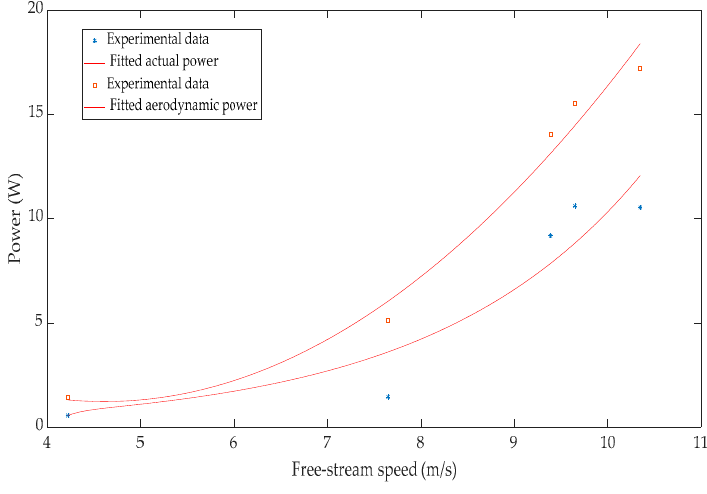
Figure 9. Power output as a function of the free-stream speed.